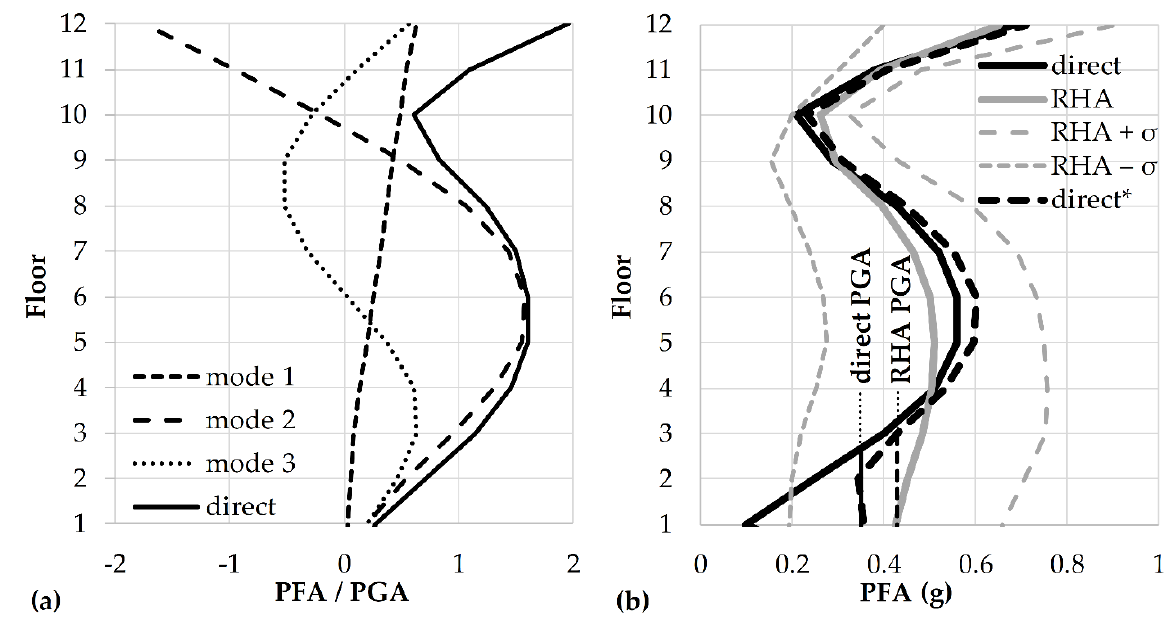
Figure 4. ( a ) PFAs from the direct method and ( b ) a comparison of the PFAs from the direct method and RHA. In Figure 4b, the direct, mean, mean plus and mean minus standard deviation values of the PFAs obtained from the direct method and RHA are presented (denoted as “direct”, “RHA”, “RHA + σ ” and “RHA − σ ”, respectively). As it can be seen, they were not normalized because the PGA values of the mean (0.43 g) and target (0.35 g) spectra were different. The PGA values of the target and mean spectra are also marked in Figure 4b, denoted as “direct PGA” and “RHA PGA”,